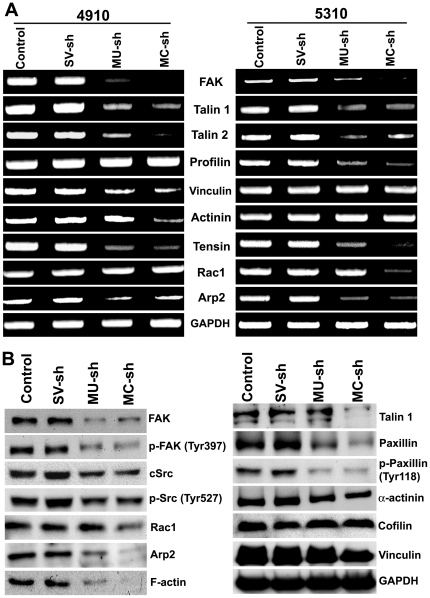
RT PCR and Western blot analysis of the molecules associated with integrin-mediated migration.(A) RT-PCR of 4910 and 5310 glioma xenograft cells transfected with scrambled vector (SV-sh), MMP-9/uPAR (MU-sh) and MMP-9/cathepsin B (MC-sh) plasmid shRNAs was performed as per standard protocol described in materials and methods. Several genes were downregulated with MU-sh and MC-sh treatments in both the xenograft cells. Results presented are the representative images of three independent experiments. (B) Western blot analysis showing the effect of bicistronic constructs (MU-sh and MC-sh) on the protein expressions of FAK, p-FAK (Tyr397), cSrc, p-Src (Tyr527), Rac1, Arp2, F-actin, talin1, paxillin, p-paxillin (Tyr118), α-actinin, cofilin and vinculin in 5310 human glioma xenograft cells. The expressions of majority of the proteins associated with integrin-mediated migration were reduced with MU-sh and MC-sh treatments. n = 3.